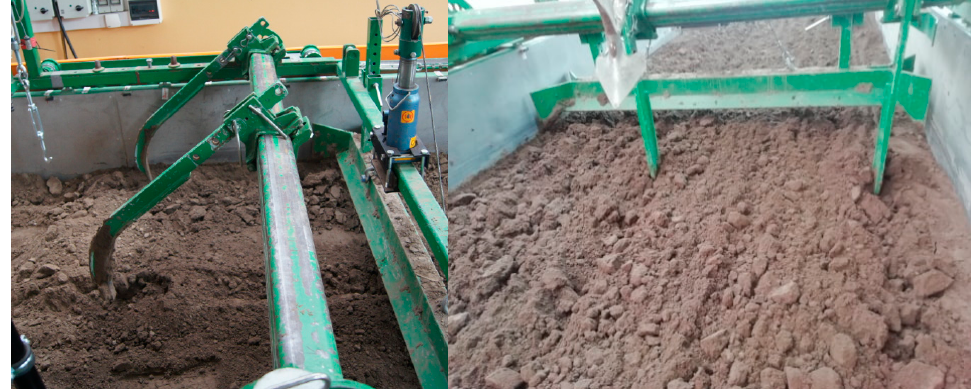
Figure 3. Subsoilers tines loosening the soil at a depth of 0.22 ± 0.02 m with a spacing of 155 ± 5 mm (for safety reasons, two tines were used in a single pass and their position was changed successively).